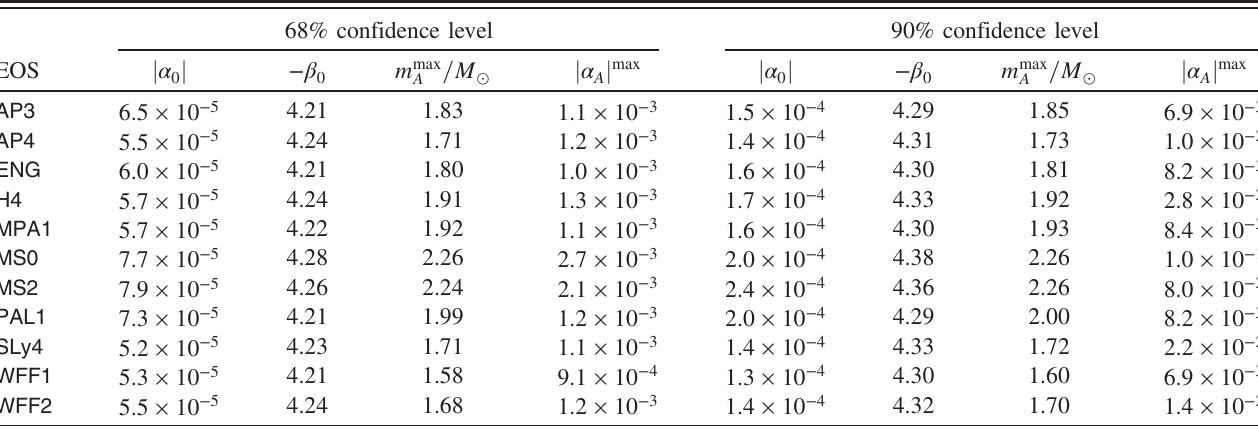
TABLE II. Limits on the parameters of the massless mono-scalar-tensor DEF theory for different EOSs when applying the MCMC analysis to the five pulsars J 0348 þ 0432 , J 1012 þ 5307 , J 1738 þ 0333 , J 1909 − 3744 , and J 2222 − 0137 . Results at 68% and max is the maximum effective scalar coupling that a NS could still possess without violating the limits, 90% C.L.s are listed. Here, j α A j and m max is the corresponding (gravitational) mass at this maximum effective scalar coupling (see Fig. A